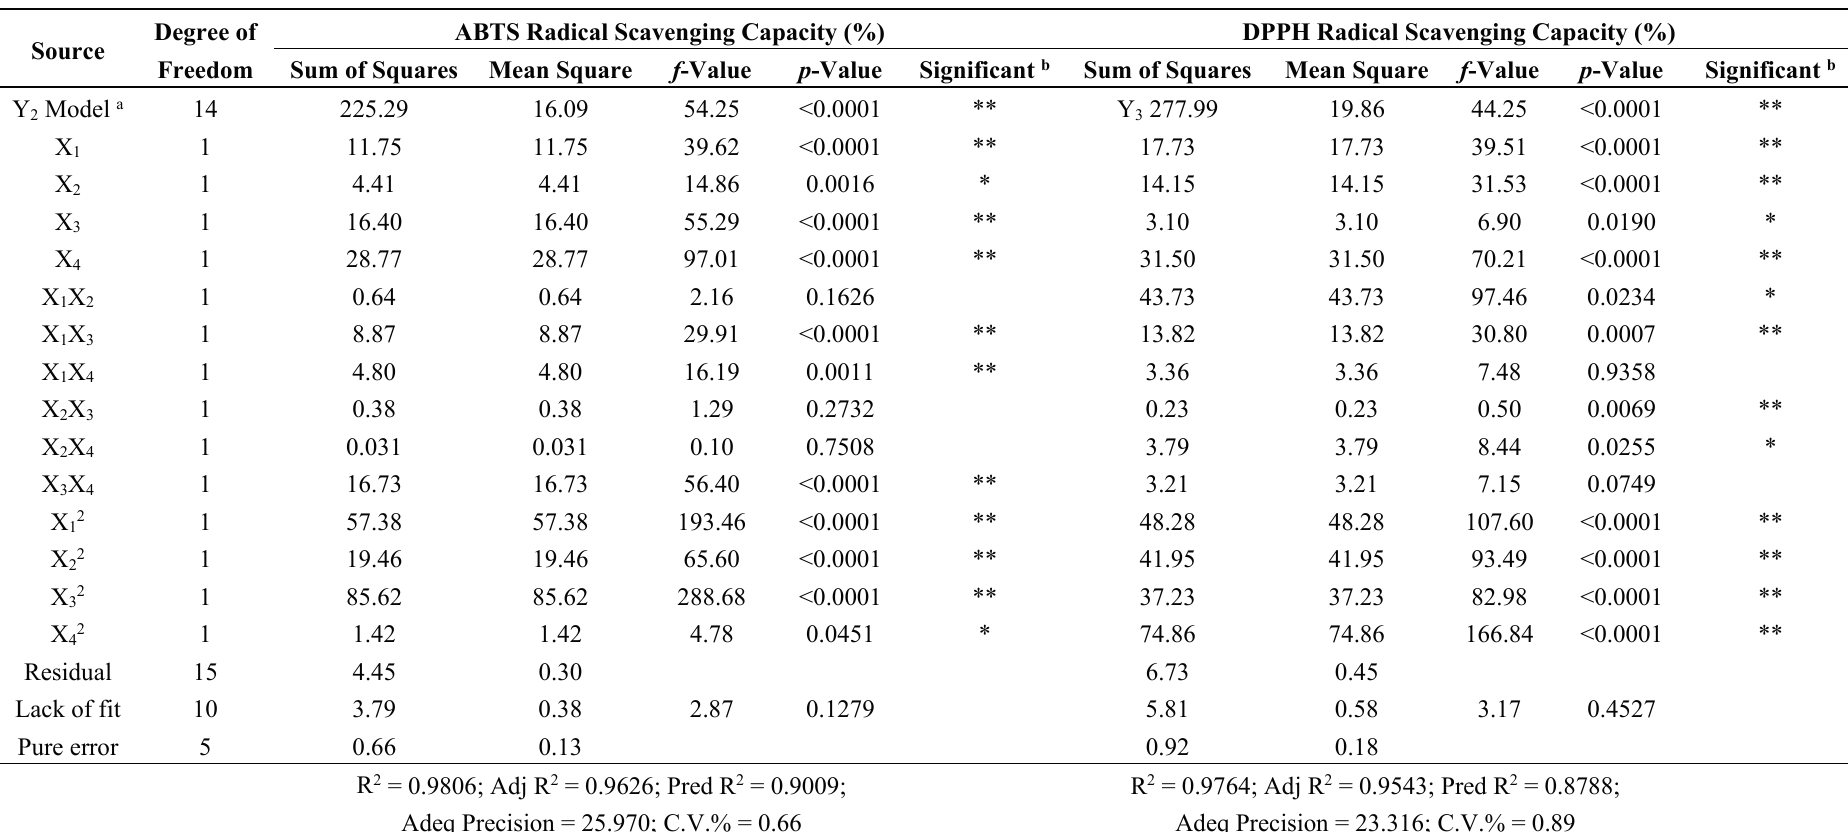
Table 4. Analysis of variance results for the multiple regressions to predict ABTS and DPPH radical scavenging capacity of extracts.